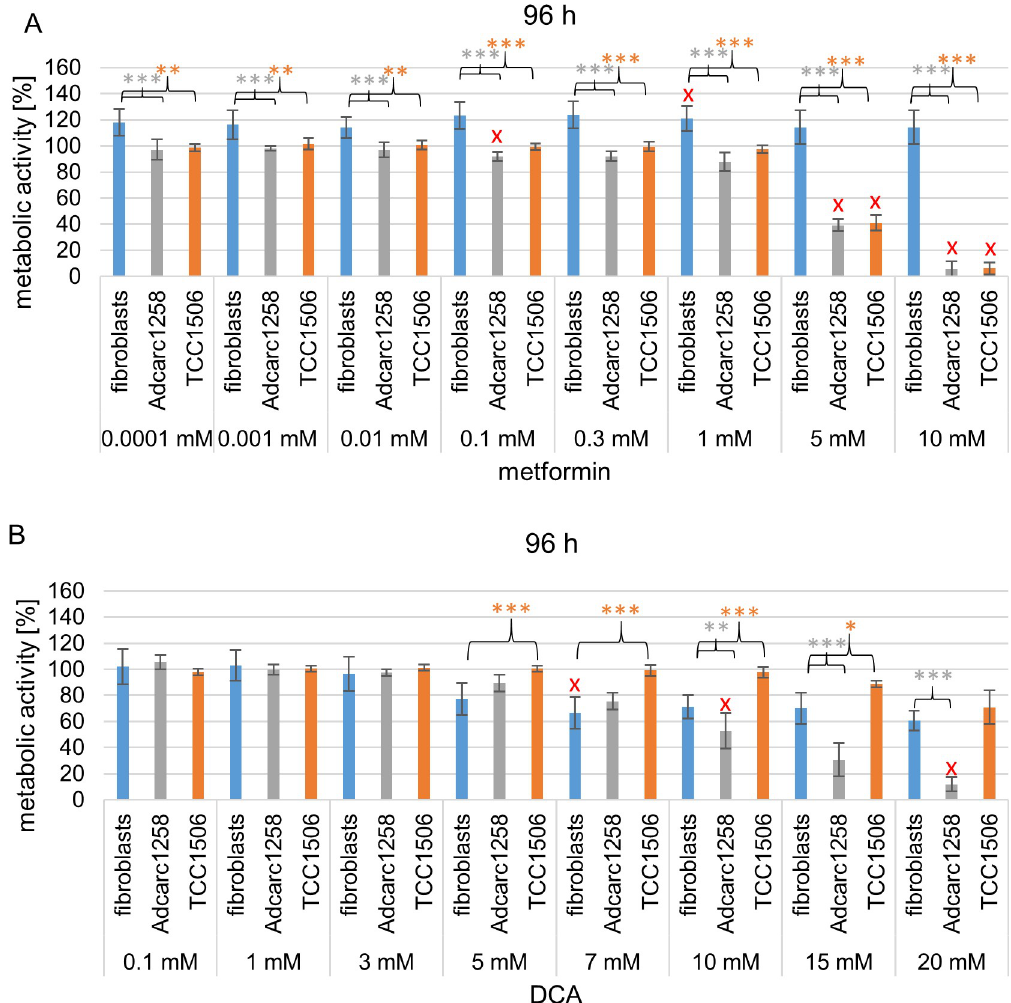
Fig 4. Metabolic activity of fibroblasts, Adcarc1258, and TCC1506 after exposure to increasing metformin (A) or DCA (B) concentrations over 96 h. An untreated control of the respective cell line served as a 100% reference. Means and standard deviation are displayed, n = 6. Gray asterisks: significance difference between fibroblasts and Adcarc1258. Orange asterisks: significant difference between fibroblasts and TCC1506. Red x: significant difference to the respective 48 h value. Significance is set at p � < 0.05, p �� < 0.01 and p ��� < 0.001,